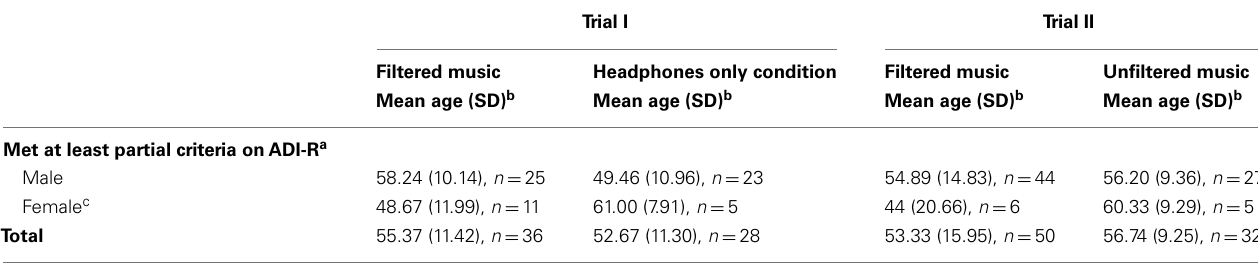
Table 1 | Demographic information for subjects with complete data by group assignment and sex